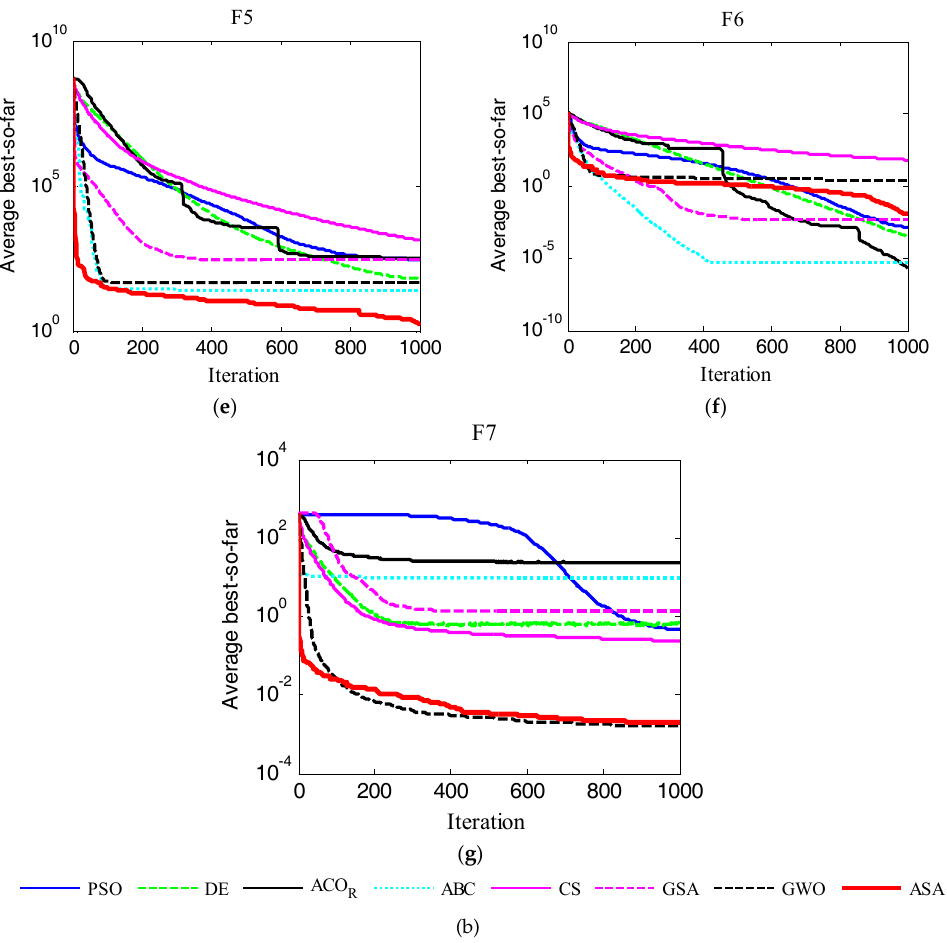
Figure 8. Comparison of performance of different algorithms for minimization of high dimensional unimodal functions. ( a ) unimodal test function F 1 ; ( b ) unimodal test function F 2 ; ( c ) unimodal test function F 3 ;( d ) unimodal test function F 4 ; ( e ) unimodal test function F 5 ; ( f ) unimodal test function F 6 and ( g ) unimodal test function F 7 .